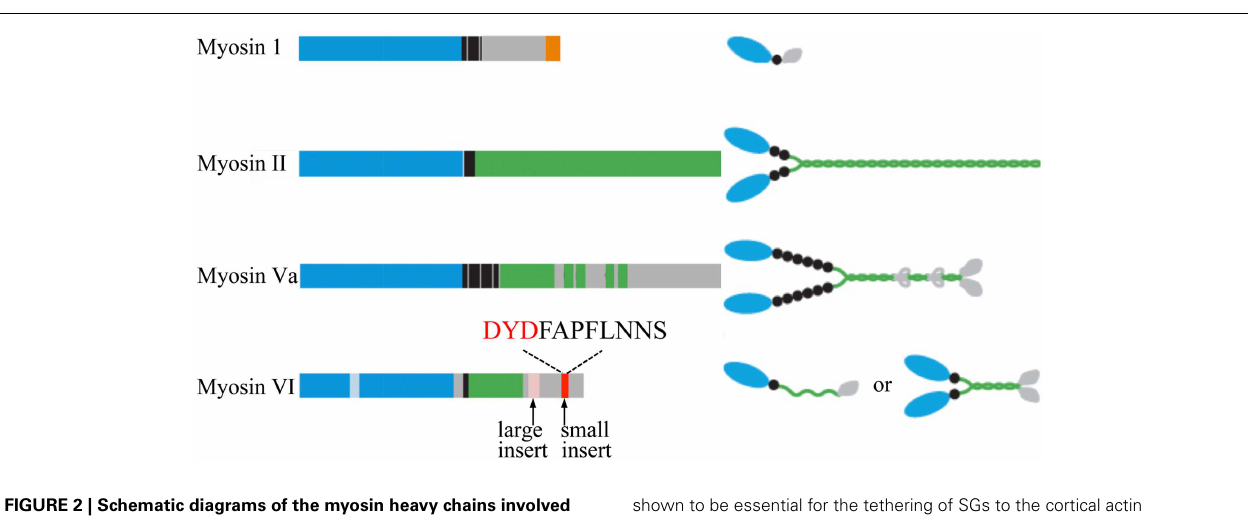
FIGURE 2 | Schematic diagrams of the myosin heavy chains involved in regulated exocytosis . All myosins consist of a head (motor) domain (blue), a neck that contains one or more IQ motifs for light chain and CaM binding (black), and a tail domain with coiled-coil regions (green) and membrane/cargo-binding domains (orange).The small insert of myosinVI,